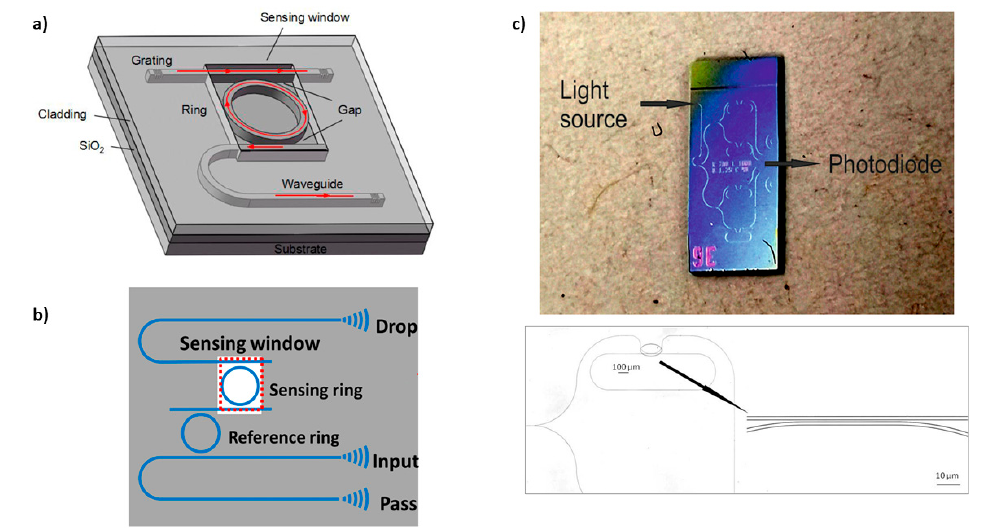
Figure 4. WGM resonator devices with an MIP functional layer. ( a ) Single microring designed by Chen et al. [122]. ( b ) Cascade microring system utilized by Xie et al. [123] with permission from Optics Express. ( c ) Microring resonator array reported by Eisner et al. [124].